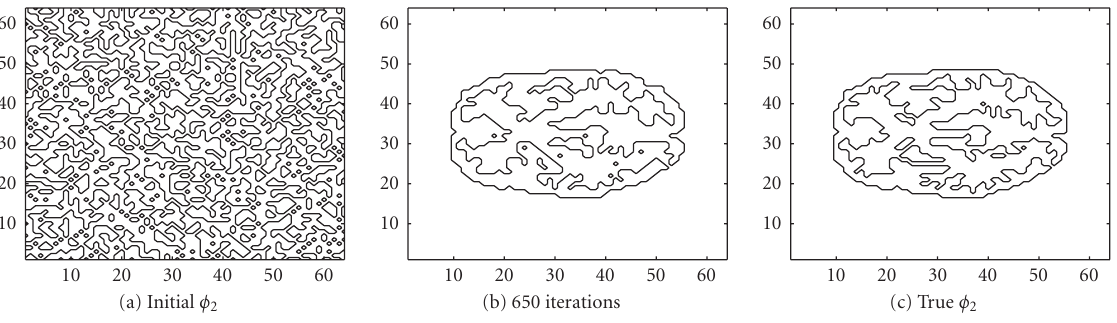
Figure 13: Interfaces given by the zero level set of φ 2 .